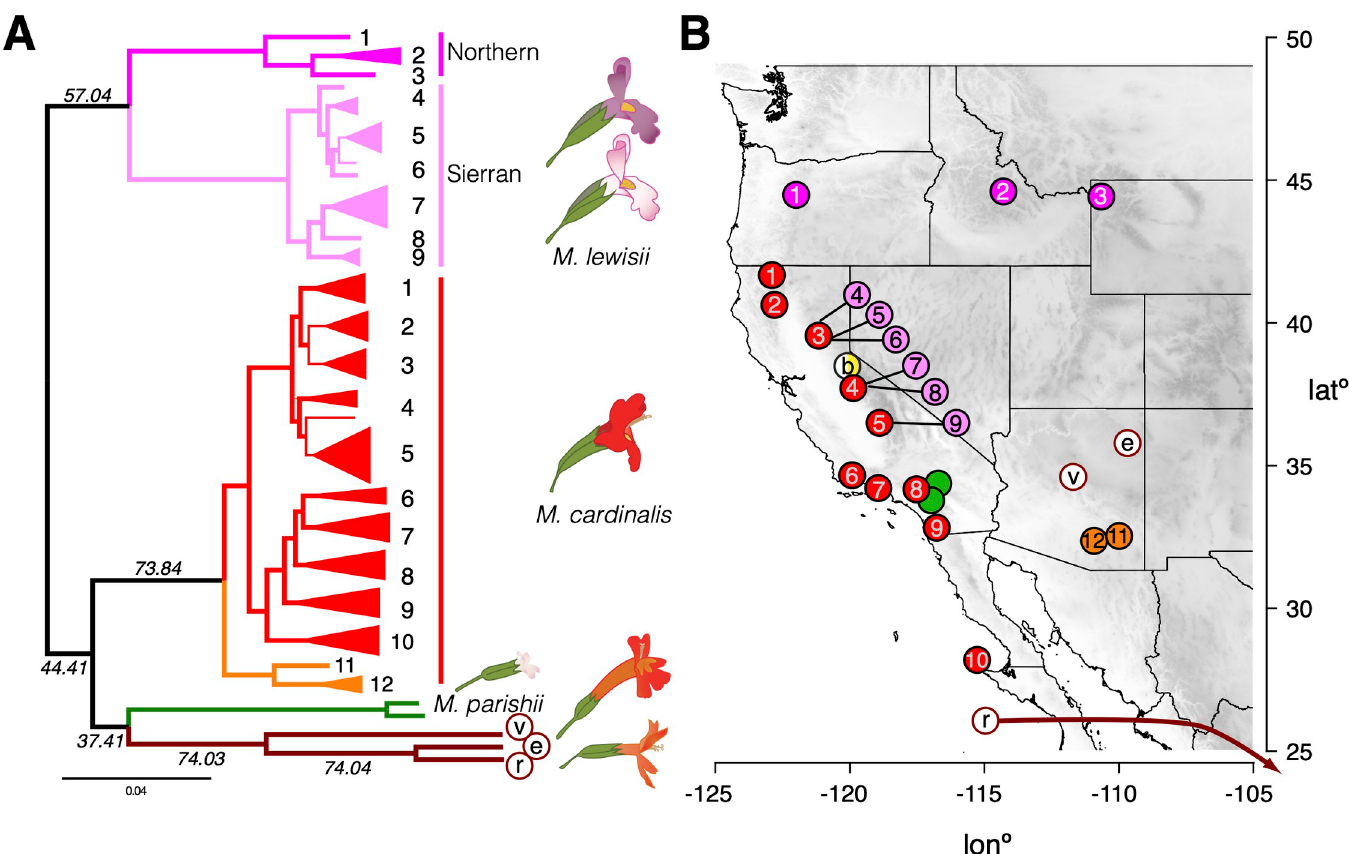
Fig 2. Genome-wide phylogeny of Mimulus section Erythranthe reveals a single clade containing all hummingbird-pollinated species. (A) The maximum likelihood phylogeny of section Erythranthe rooted to M . bicolor . The species level topology is identical to that inferred with ASTRAL 3. Branches with bootstrap support > 90% are bold. Quartet scores are also given for branches included in the ASTRAL species tree. Clades representing a single collection location are collapsed (see S18 Fig for the unrooted phylogeny including the branch to M . bicolor ). Numbers next to M . lewisii and M . cardinalis tips refer to collection locations in B. (B) Collections of section Erythranthe across the American West. Sierran M . lewisii collections are offset due to close overlap with M . cardinalis collections in the Sierra Nevada Range. Location of the M . rupestris accession from Central Mexico not shown (see S1 Table). ‘b’: M . bicolor ; v: M . verbenaceus ; ‘e’: M . eastwoodiae ; ‘r’: M . rupestris